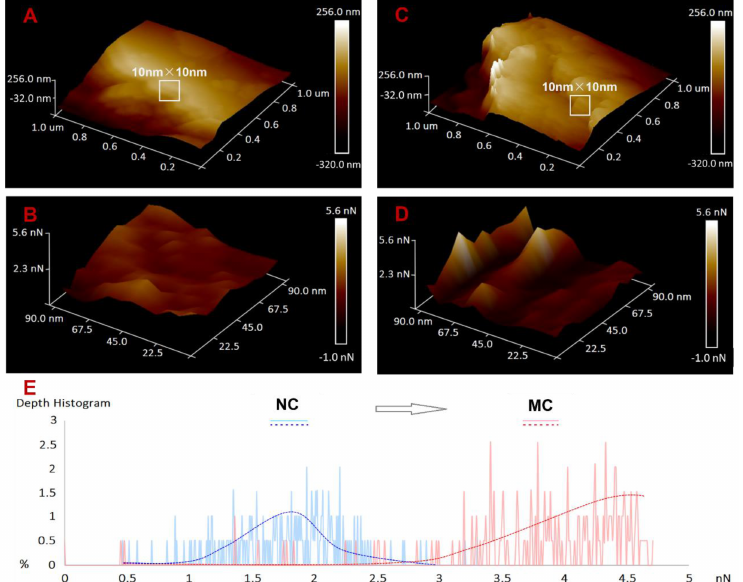
Figure 7. NC and MC morphology and adhesion distribution map measured by atomic force microscopy. ( A ) Three-dimensional image for morphology of NC; ( B ) three-dimensional image for morphology of MC; ( C ) three-dimensional image for adhesion distribution of NC; ( D ) three- dimensional image for adhesion distribution of MC; ( E ) the adhesion values distribution for NC and